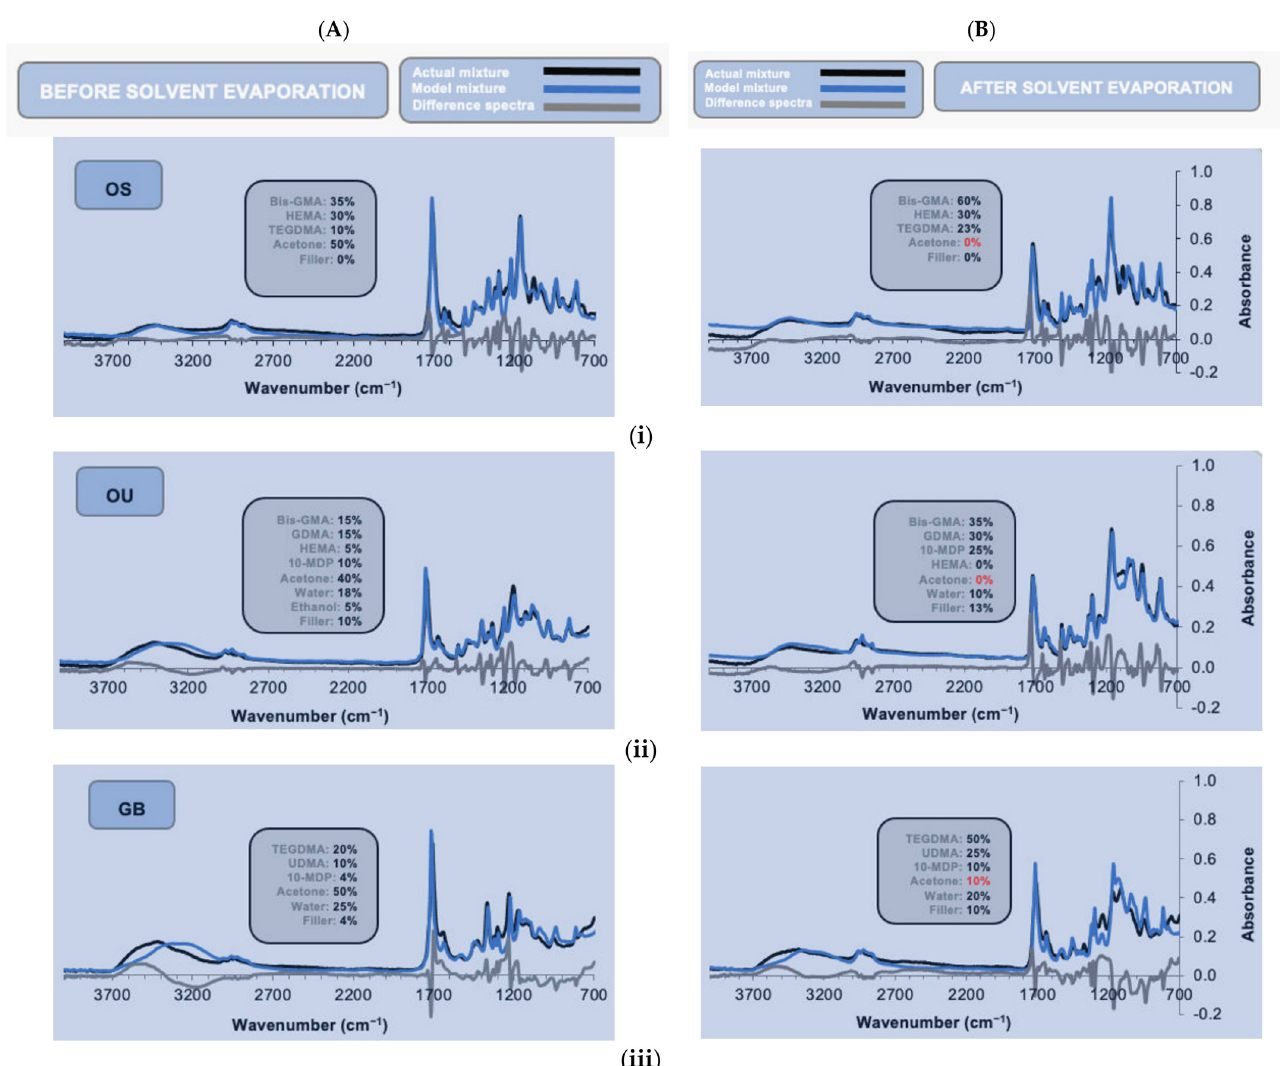
Figure 3. ATR–FTIR spectra of adhesives ( i ) OS, ( ii ) OU, and ( iii ) GB, featuring the actual mixtures (in black), model spectrum (in blue), and difference spectrum between the two spectra (in grey), ( A ) before and ( B ) after solvent